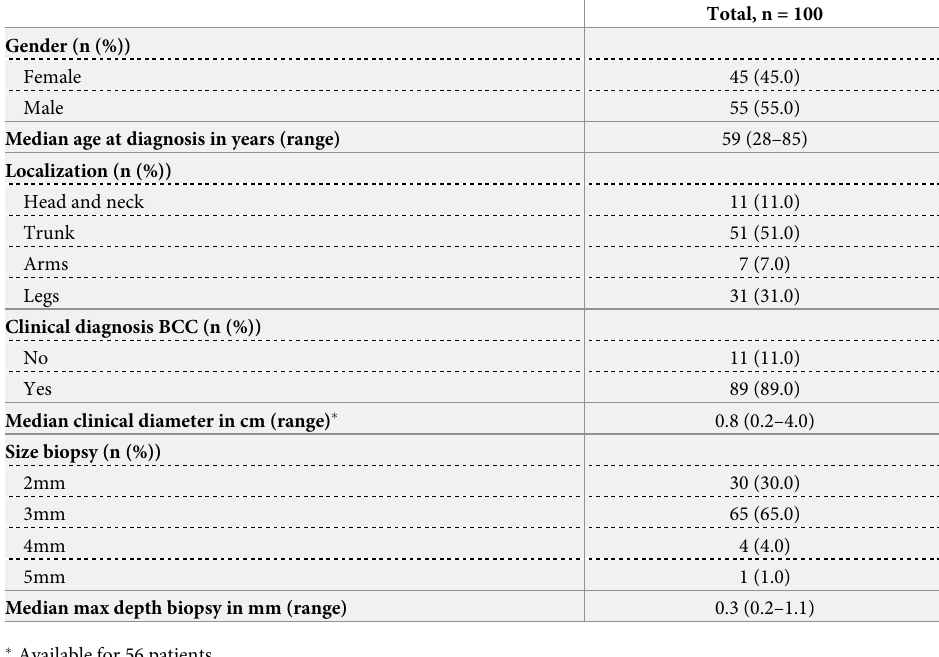
Table 1. Clinicopathological characteristics of all included